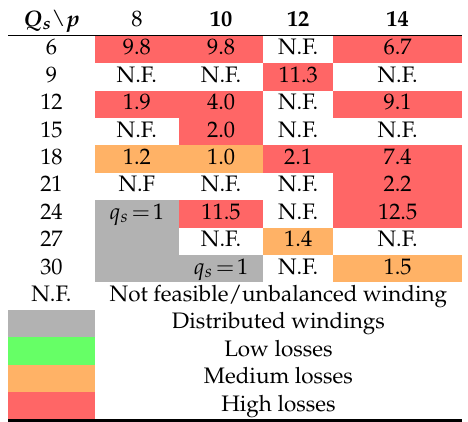
Table 2. p m (W/cm 3 ) for l m = 30 mm at 9000